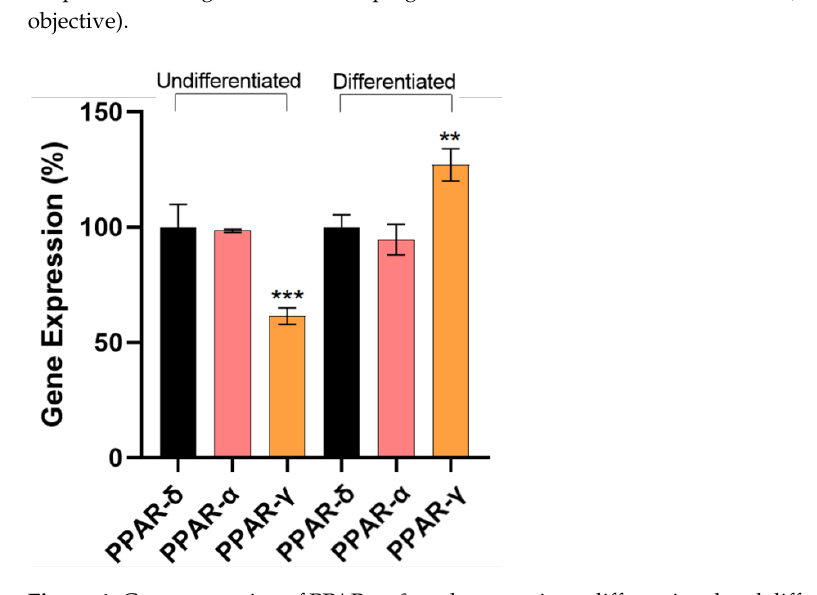
Figure 4. Gene expression of PPAR- α , δ , and γ genes in undifferentiated and differentiated adipocytes. The results were normalized to 100% of PPAR- δ expression. The assay was performed in triplicate. p values of <0.05 were considered statistically significant. ** means p < 0.01 and *** means p < 0.001